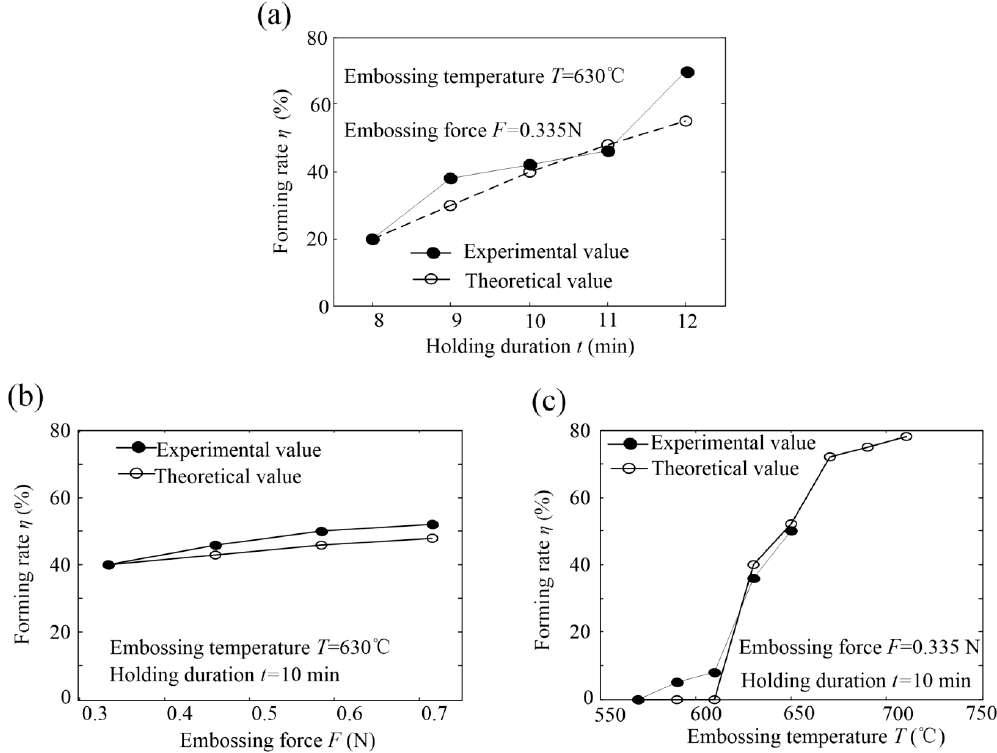
Figure 9. Theoretical and experimental forming rates of glass-microprism array: ( a ) forming rate η versus holding duration t ; ( b ) forming rate η versus embossing force F ; ( c ) forming rate η versus embossing temperature T .